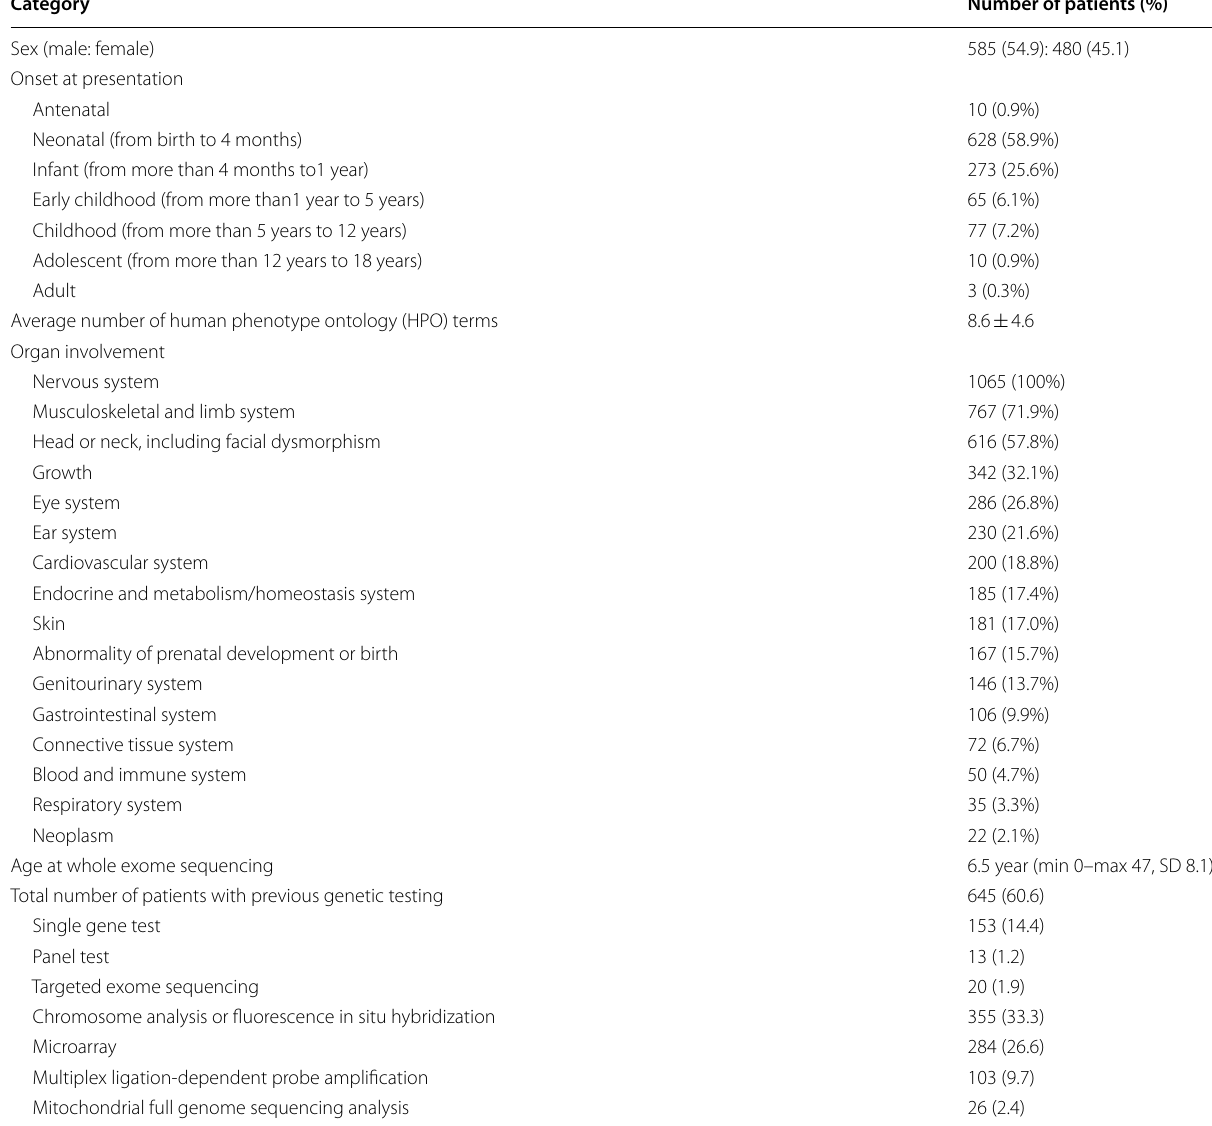
Table 1 Demographics of patients with neurodevelopmental delay/intellectual